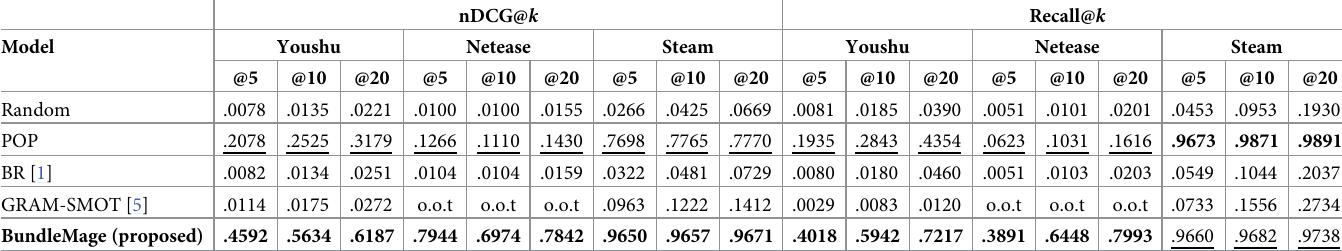
Table 4. Performance of BundleMage and competitors for bundle generation with respect to nDCG and